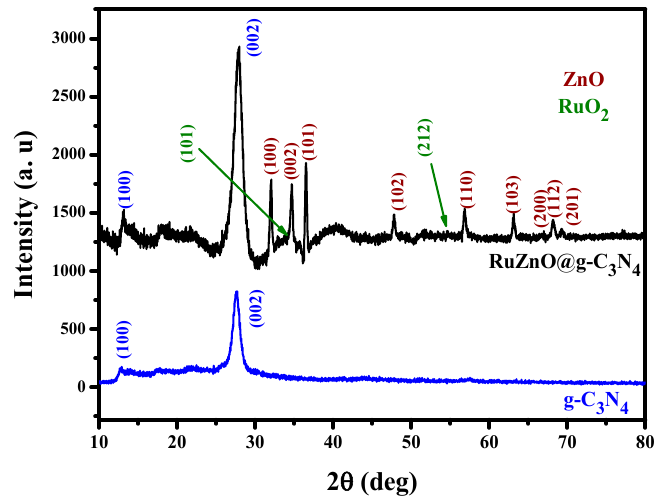
Figure 1. XRD patter of g-C 3 N 4 , and Ru-ZnO@g-C 3 N 4